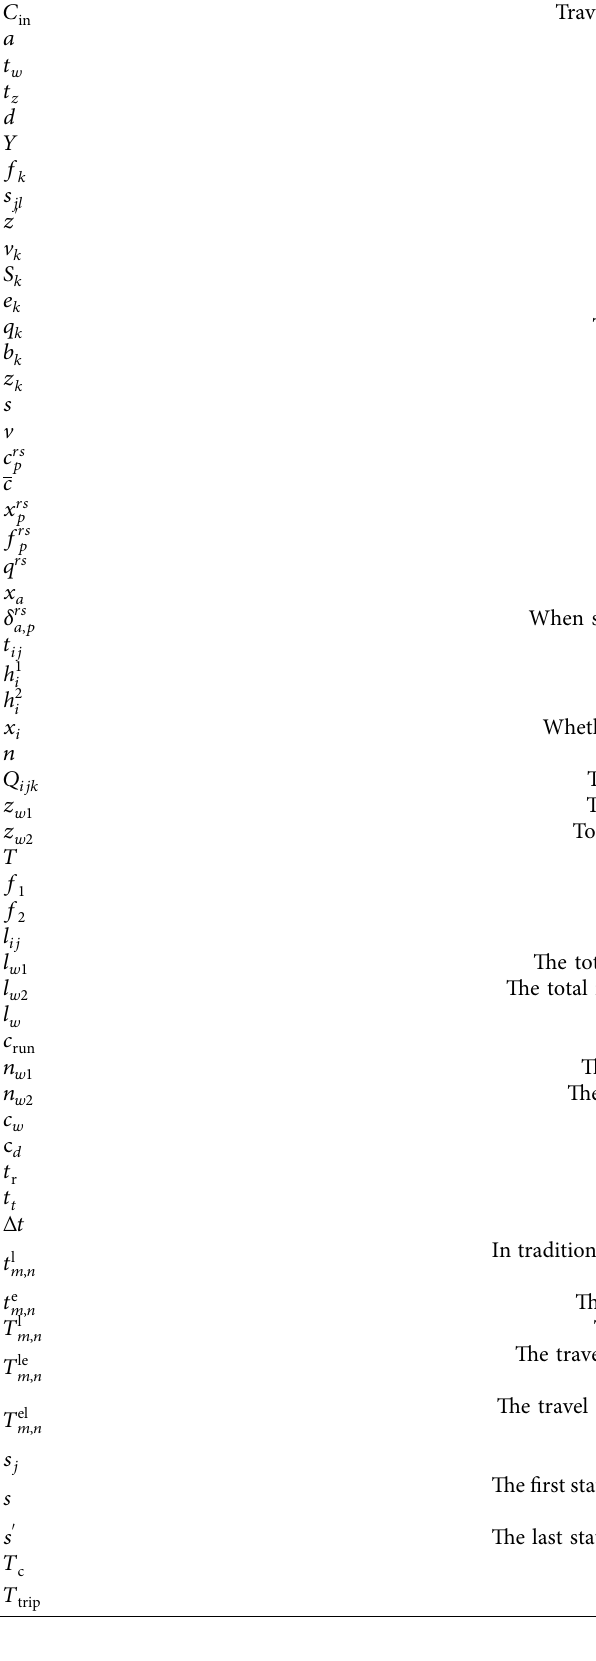
Table 1: Notations and parameters used in the